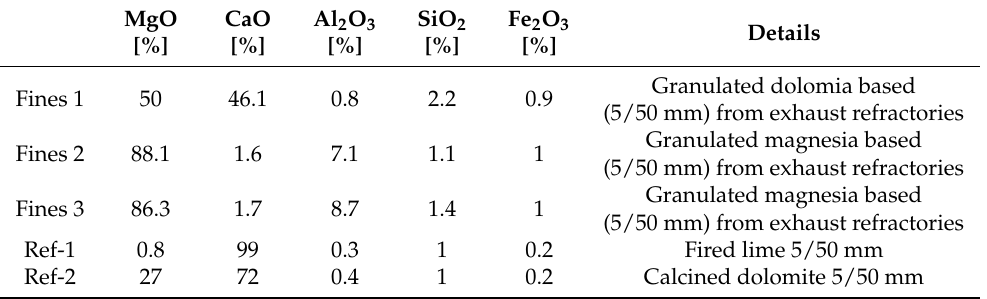
Table 2. Average chemical analysis of materials reused in ReStoRe project compared with fired lime and calcined dolomite used in steelworks